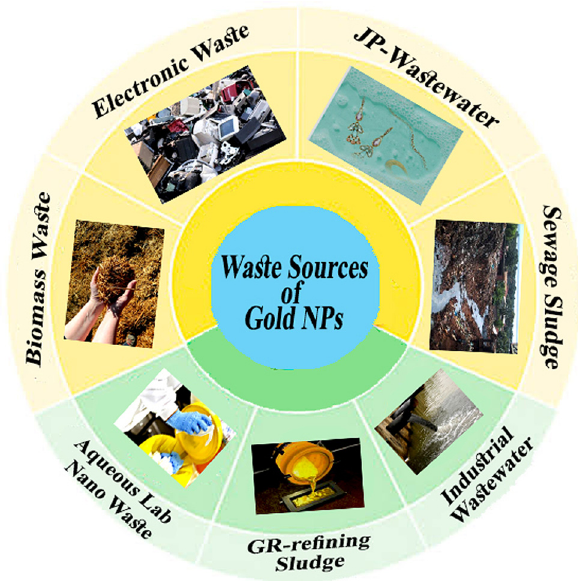
Figure 27: Waste sources for gold nanoparticle